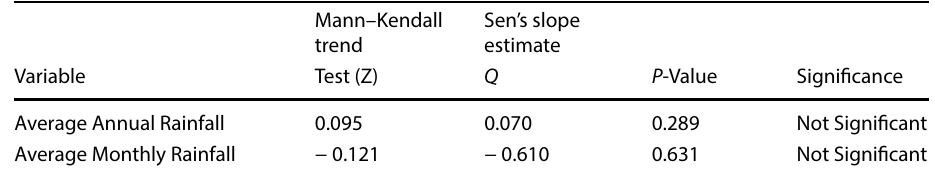
Table 5 Trend Analysis for Dera Ismail Khan Station from 1960 to 2020. Source : Pakistan Meteorological Centre